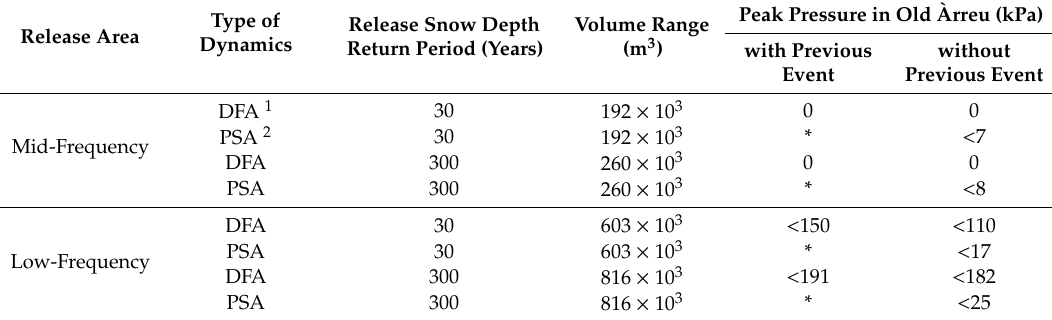
Table 3. Summary of simulations.